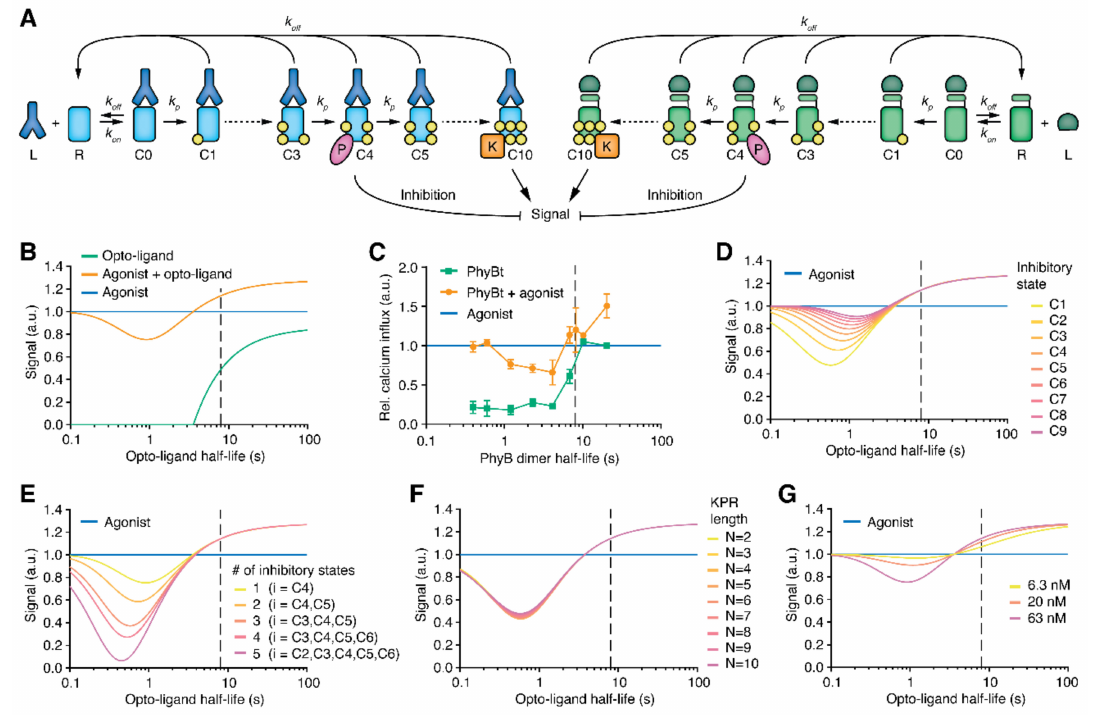
Figure 4. Mathematical model. ( A ) Schematic representation of the C10 Signal Inhibition model, combining two KPR schemes, one for each ligand-TCR pair (left: agonist; right: opto-ligand). The activating signals by the final state C10 can be reduced by inhibitory signals induced by the intermediate state C4. Ligand-receptor association rate k on and KPR step rate k p are the same for both submodels. The dissociation rate k of f is submodel-specific. ( B ) The signal vs opto-ligand binding half-life for each ligand alone and for their combination was calculated by the C10 Signal Inhibition model. ( C ) Data from Figure 3B with the 660 nm intensity converted to ligand binding half-life. ( D – G ) C10 Signal Inhibition model results varying the position of the inhibitory state ( D ), the number of inhibitory states ( E ), the number of KPR steps ( F ), or the opto-ligand concentration ( G ). In ( F ), the state C1 has been used as the inhibitory state. The opto-ligand concentration in ( B – F ) is 63 nM. The dashed line in ( B – G ) marks τ KPR = 8